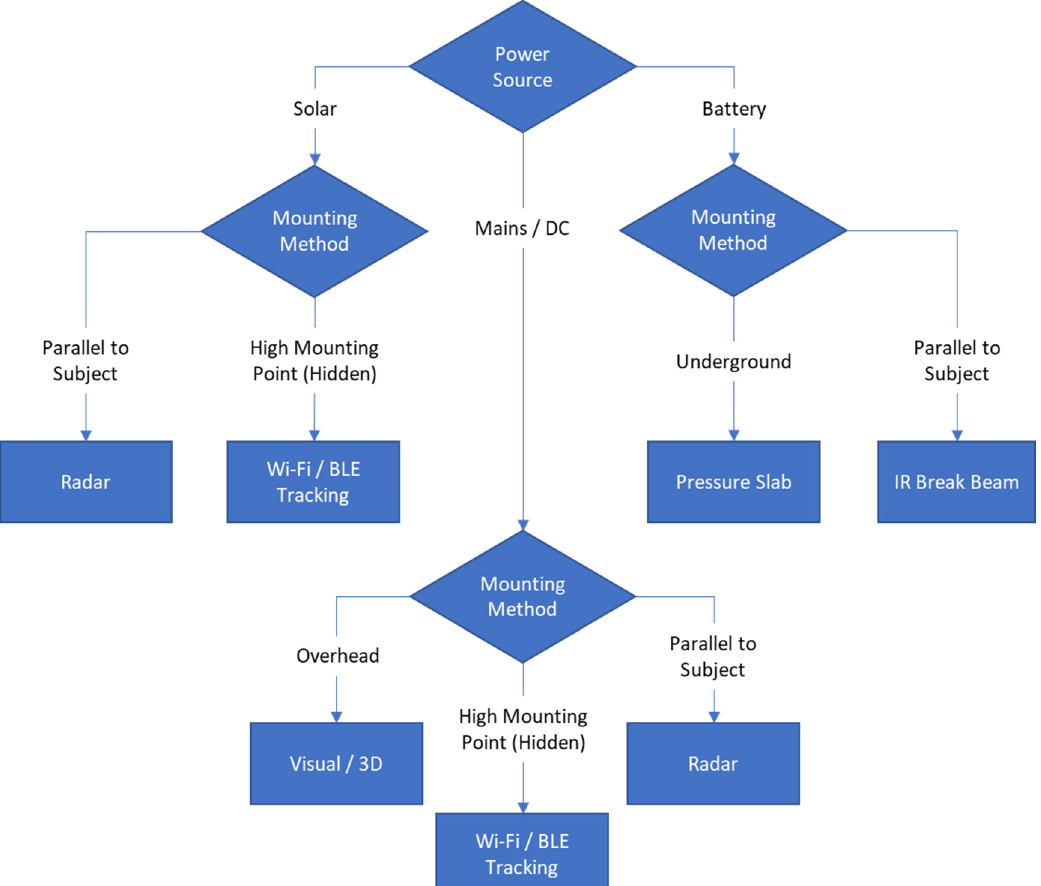
Figure 8. Sensor Technology Decision Tool (Developed from TGs sensor technology scoping study).